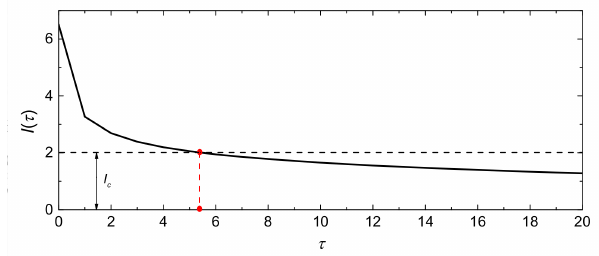
Figure 5. Mutual information with τ from 0 to